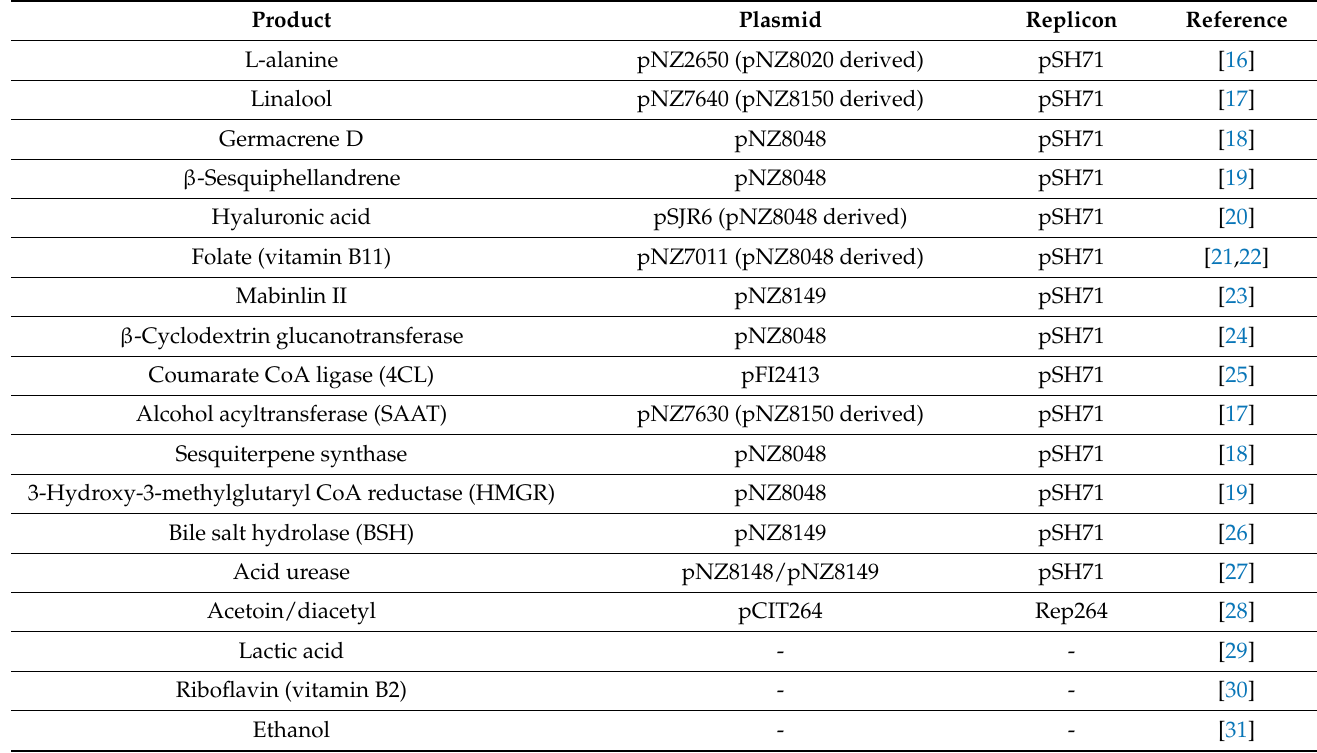
Table 1. Main proteins and metabolites suitable for industrial production by Lactococcus lactis